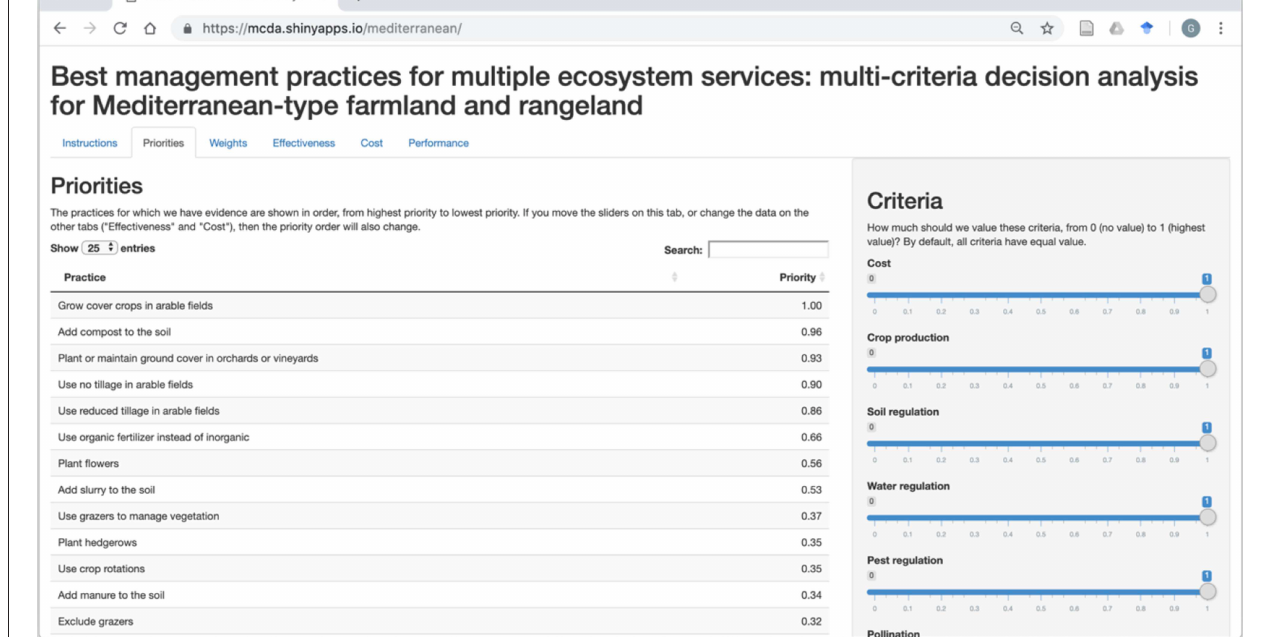
outcomes (“TNC priorities”). Three people used the web